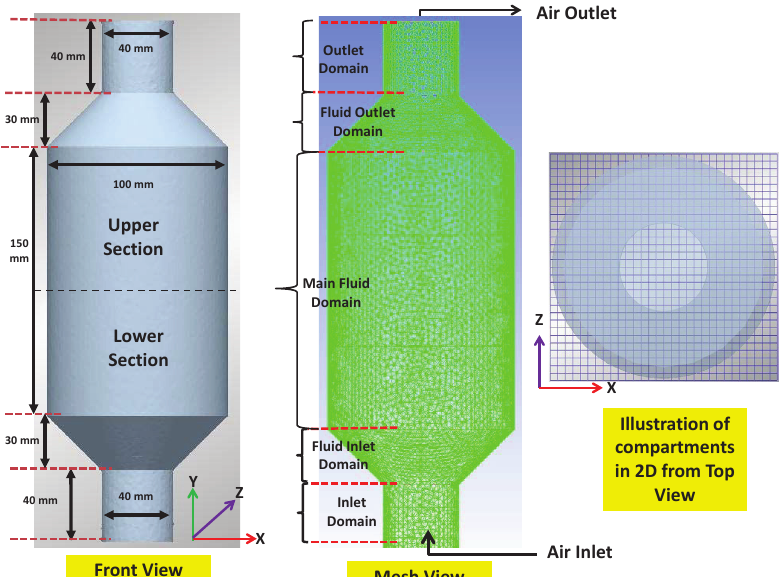
Figure 2. Model Geometry and mesh of the